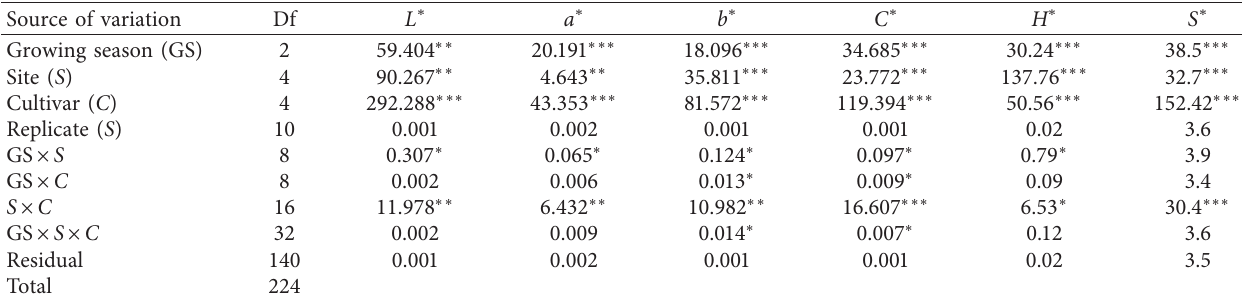
Table 1: Mean squares of the combined analyses of variance for brightness index ( L ∗ ), redness index ( a ∗ ), yellowness index ( b ∗ ), chroma ( C ∗ ), hue angle ( H ∗ ), and metric saturation ( S ∗ ) of five almond cultivars grown in different sites of north-eastern Morocco (Aknoul, Bni Hadifa, Tahar Souk, Rislane, and Sidi Bouhria) during three growing seasons (2016 − 2018).